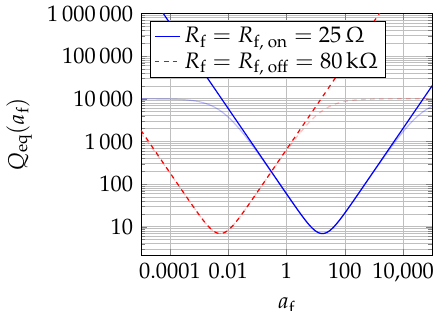
Figure 2. Q factor, Q eq ( a f ) , for a 3pF capacitor in parallel with a series combination of a fuse and a 1pF capacitor, plotted as a function of fuse scaling factor, a f . Q eq ( a f ) is plotted for both active and blown fuses corresponding to different fuse resistances. Plots for manufactured capacitors with both infinte Q factors and Q factors of 10000 are shown, with the latter case in a lighter